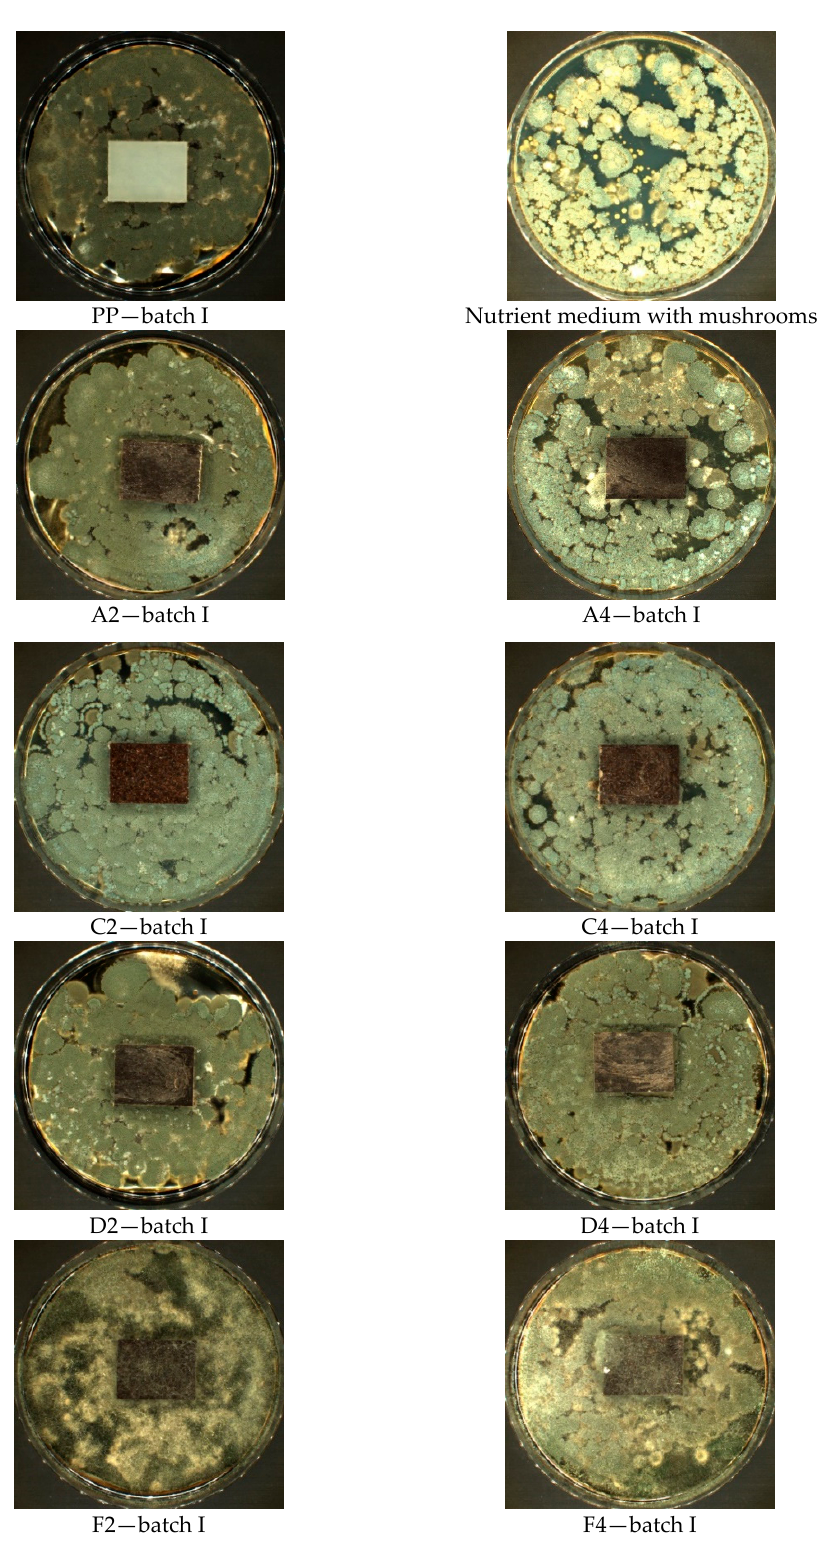
F4—batch I Figure 3. Method A—results of visual assessment of samples; photos of batch samples: I.